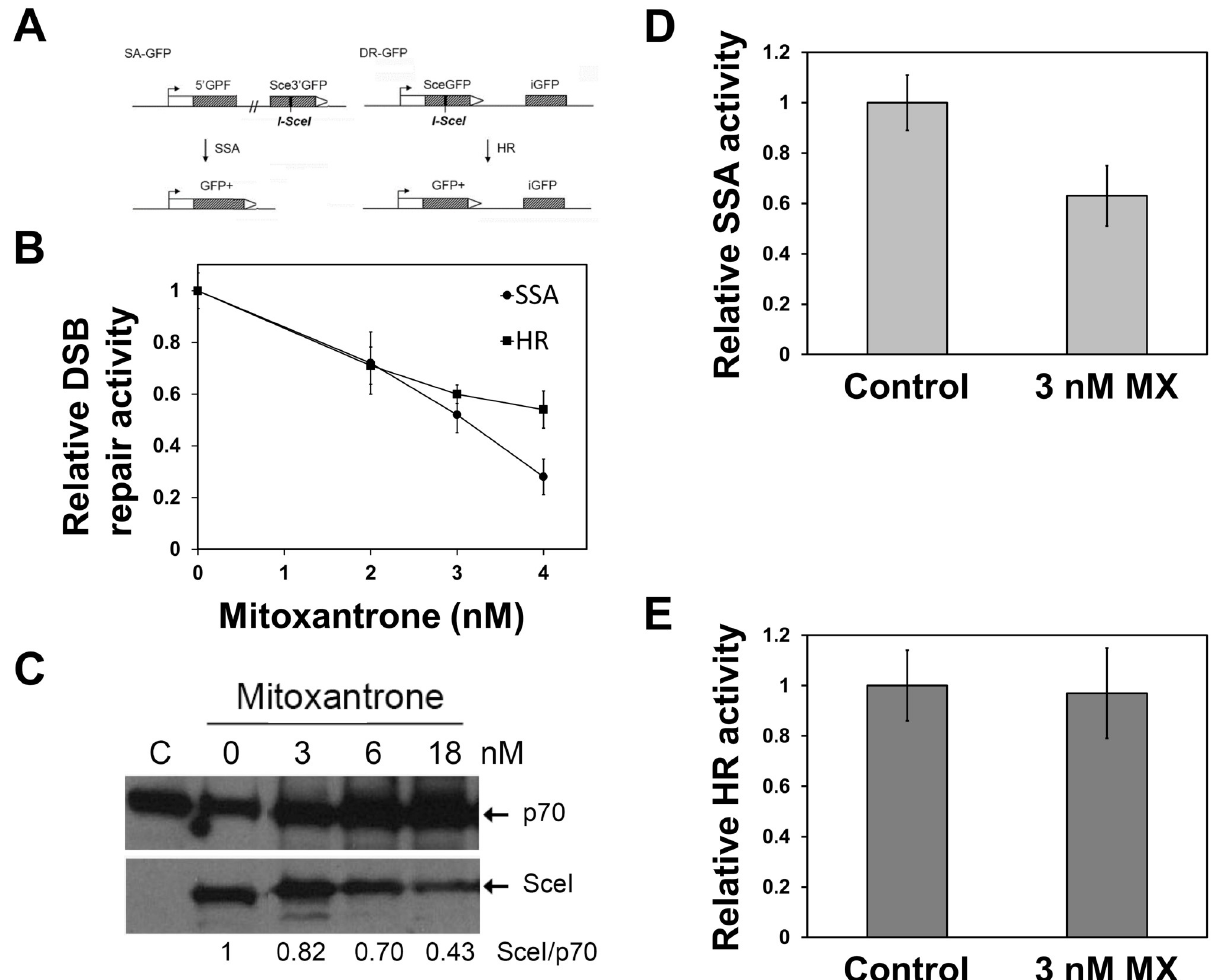
Fig 7. RAD52 inhibitor mitoxantrone selectively suppresses SSA. (A) The effect of mitoxantrone (MX) on SSA and HR were studied with cell-based DSB repair assays. U2OS-SA and U2OS-DR cells were pre-treated with mitoxantrone for two hours before transfection of the SceI-expression plasmid. Then cells were grown in the presence of mitoxantrone for three days. DSB repair activities were determined by (B) FACS analysis. FACS data are provided in S3 Fig. (C) Inhibition of the expression of I-SceI (SceI) by mitoxantrone. U2OS-SA cells were pre-treated with indicated concentrations of mitoxantrone for two hours, before I-SceI-expression vector transfection. After 72 hours incubation, the cells were harvested, and lysates were prepared. Lysate from each treatment was analyzed by 12% SDS-PAGE and the expression levels of I-SceI was determined by the western blot using anti-HA antibody. The p70 of RPA was used as a loading control. Ratios of I-SceI to p70 was obtained with ImageJ and are shown at the bottom of the image. C: control experiment without the addition of mitoxantrone. (D, E) Analysis of DSB repair activiies by western blots. Graphs showed relative DSB repair activities with mitoxantrone to control experiments without mitoxantrone. At least three independent experiments were performed. Error bars represent standard deviations. The differences between the SSA inhibition and the HR suppression by mitoxantrone were statistically significant (p < 0.05 at 4 nM, and p < 0.05 at 3 nM). Western blot data are provided in S4